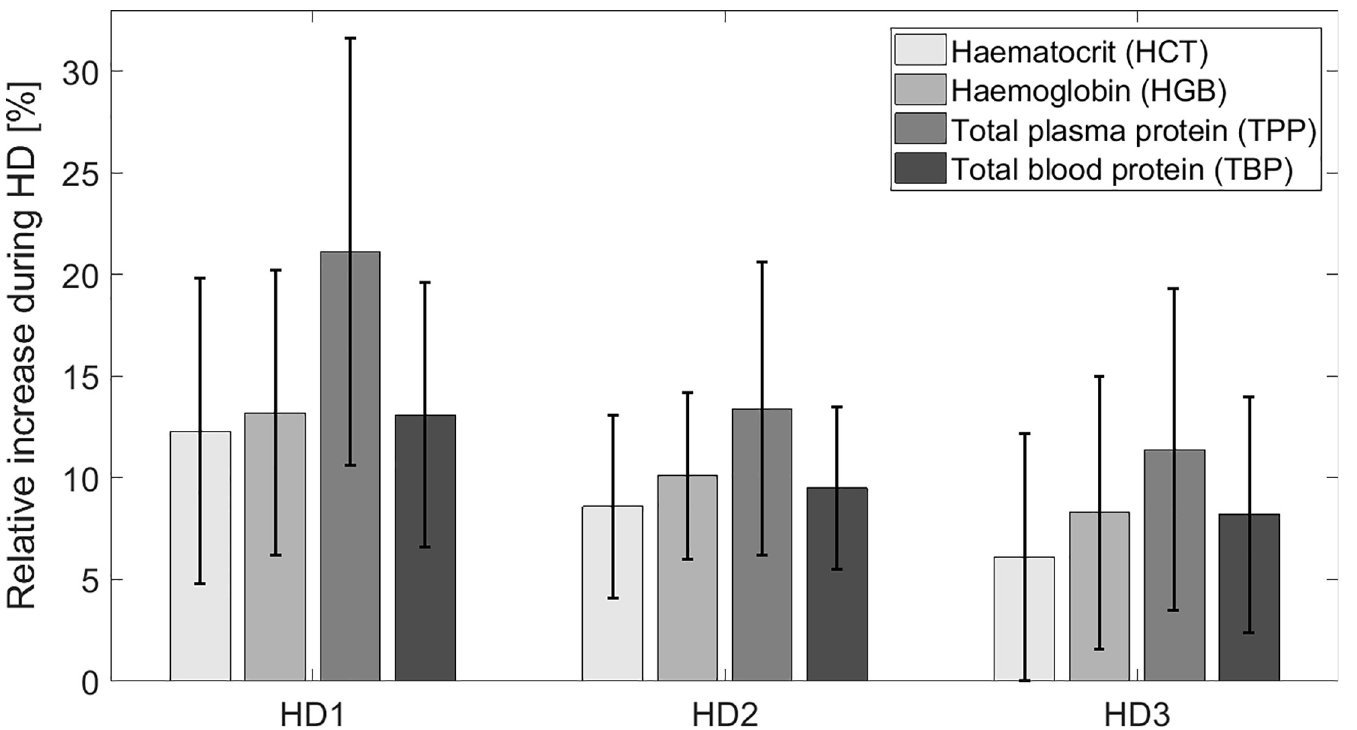
Fig 1. Dialysis-induced changes in hematocrit, hemoglobin, total plasma protein and total blood protein. Relative increase (mean ± SD) of hematocrit (HCT), hemoglobin (HGB), total plasma protein (TPP) and total blood protein including hemoglobin (TBP) during three consecutive HD sessions in the week in the analyzed group of patients based on the laboratory measurements of arterial blood samples taken at the beginning and at the end of each session (see Table 3). For all three averaged HD sessions the differences in dialysis-induced relative increase between HCT and HGB, and between HGB and TPP were all statistically significant (p < 0.02), except for the difference between HCT and HGB in the first HD session (p = 0.23). The changes of HGB and TBP during HD 1 and HD 3 were almost equal (p = 0.81 and p = 0.63, respectively); for HD 2 there was a significant (p < 0.02), but very small difference